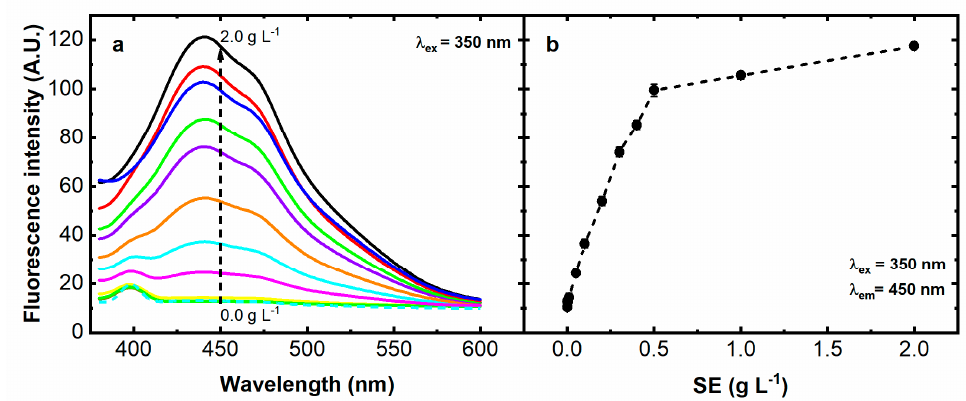
Figure 4. Influence of the serotonin monomer concentrations (0, 0.001, 0.005, 0.010, 0.050, 0.100, 0.200, 0.300, 0.400, 0.500, 1.000, and 2.000 g L − 1 ) on the emission signal of the serotonin-derivative fluorophore synthesized after 2 h at 60 °C in alkaline conditions (pH 9.00). The fluorescence emission spectra upon excitation at 350 nm ( a ) and corresponding fluorescence emission intensity at 450 nm ( b ). The error bars represent the standard deviation (n = 4).